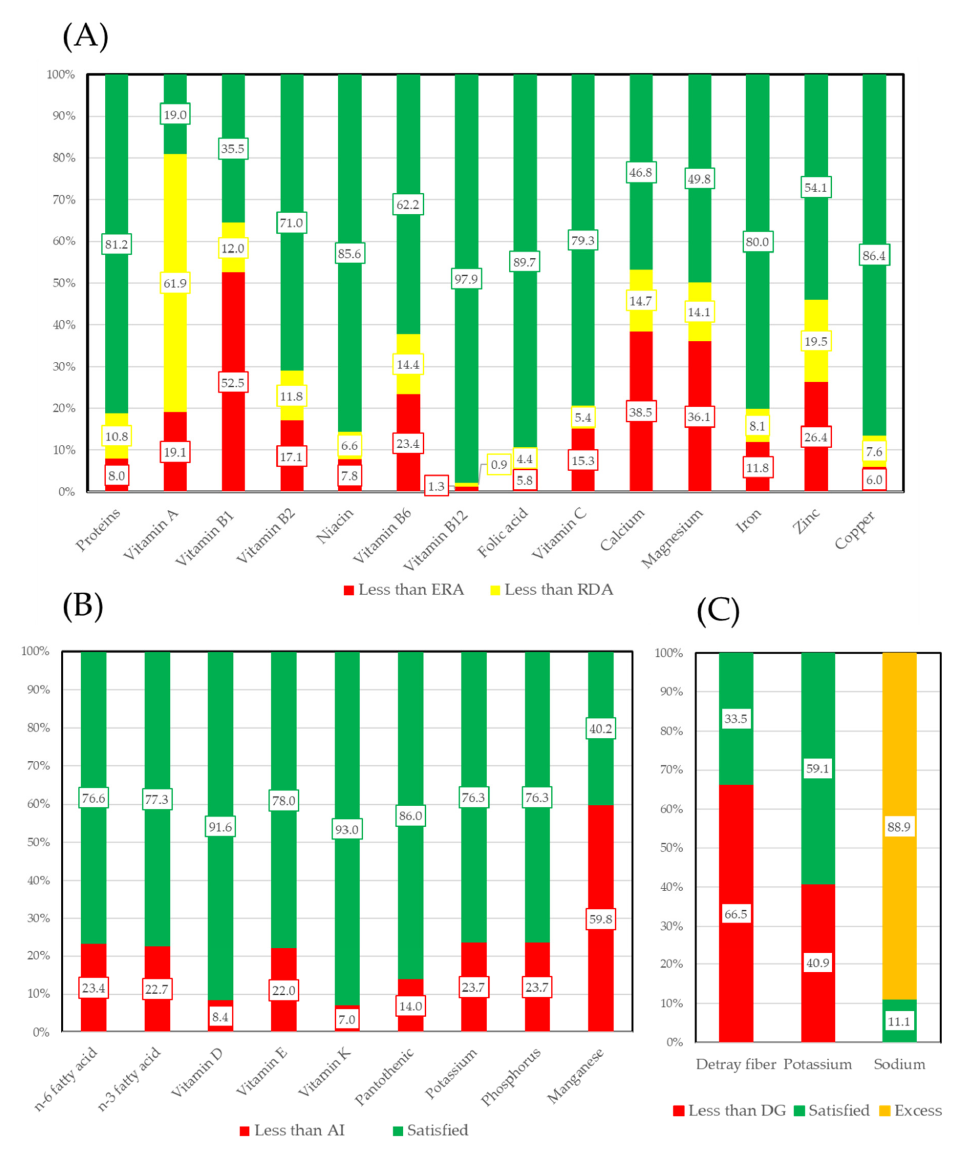
Figure 2. Meeting of vitamins, macro minerals, and micro minerals. Levels were determined